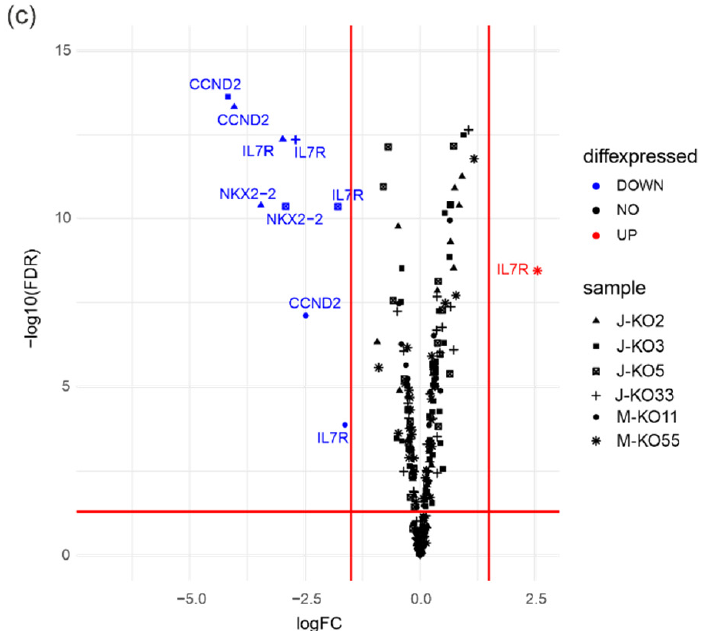
Figure 5. Effects of PRMT7 deletion on gene expression in T-ALL cells. Volcano plots displaying the differentially expressed genes (log2FC ≥ ± 1.5, FDR < 0.05) in ( a ) J-KO3 and ( b ) J-KO5 cell lines. ( c ) A volcano plot displaying gene expression changes (log2FC ≥ ± 1.5, FDR < 0.05) in genes known to be associated with T-ALL pathogenesis and altered in all six PRMT7 knockout cell lines labeled with different symbols. Red color indicates genes with increased and blue with decreased expression compared to unmodified cells. Three biological replicates were combined for the analysis for each cell line. J stands for Jurkat and M for Molt4 cell line, EV for empty vector and WT for wild type.